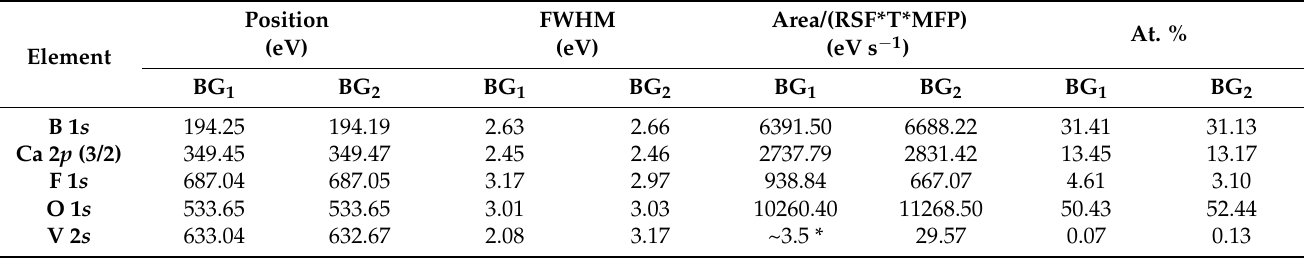
Figure 1. XPS spectra of F 1 s , V 2 s , Ca 2 p , and B 1 s core-level lines corresponding to sample BG2. Table 1. The XPS line positions, FWHM, normalized areas, and At. % composition at ~5.3 nm depth for samples BG1 and BG2. The value marked by * was at the limit of detection and was thus ruled out.